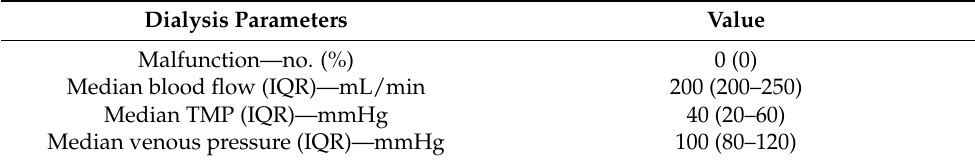
Table 5. Retrograde-tunneled HDC performance